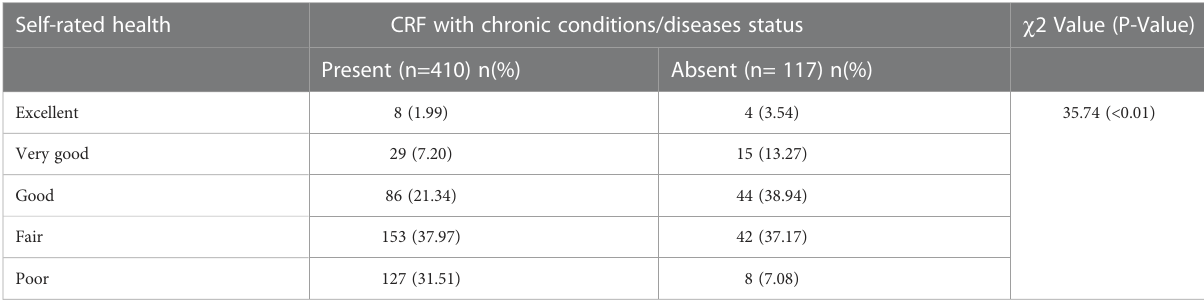
TABLE 3 Self-rated health pro fi le of CKD with chronic conditions/ disease status among (18+) adult population in India (LASI) wave 1, 2017-18. Self-rated